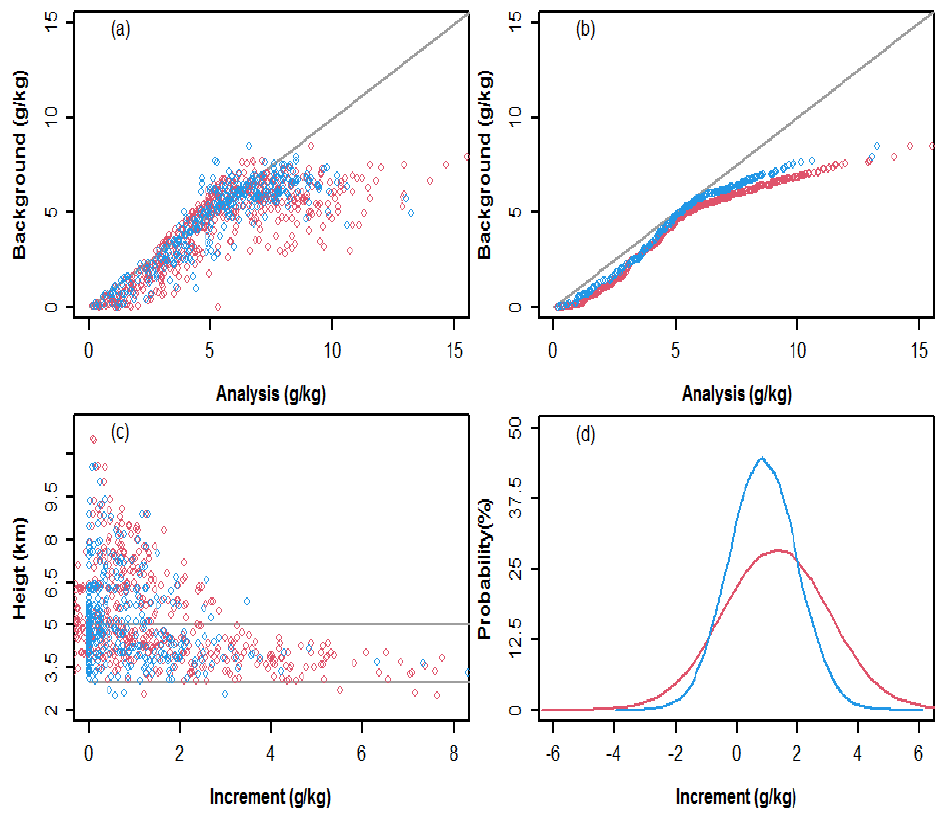
Figure 16. Diagnostic plots of water vapor (unit g/kg). ( a ) Scatter distribution of water vapor mixing ratio between analysis and background. ( b ) QQ distribution of water vapor mixing ratio. ( c ) The distribution of the analysis increment at different altitudes (unit m) of ground above sea level. ( d ) PDF distribution of the analysis increment. The blue lines and circles indicate E3RadBy, and the red lines and circles indicate E2Rad.